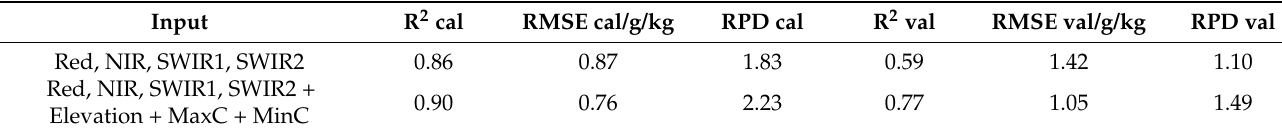
Table 6. Prediction results of RF models with different inputs.